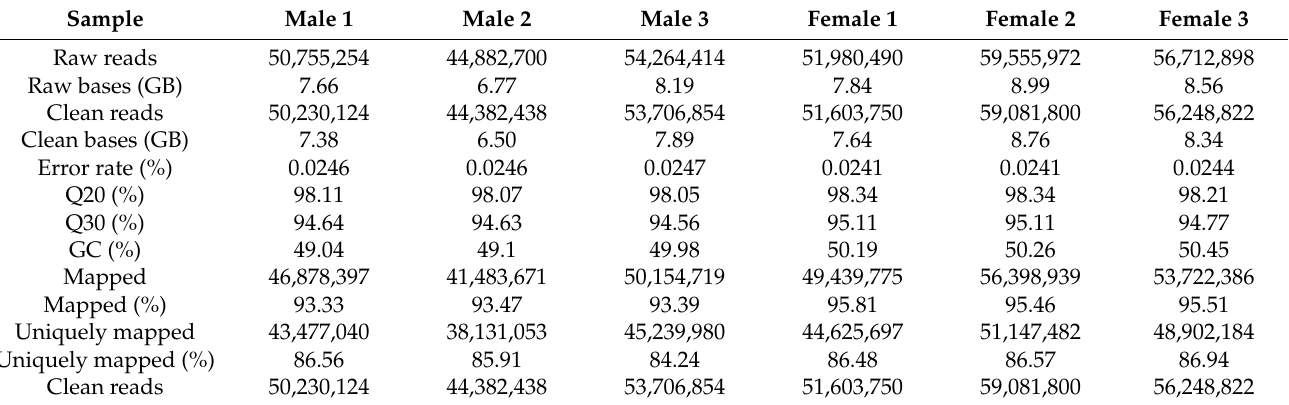
Table 1. Transcriptome sequencing data statistics.